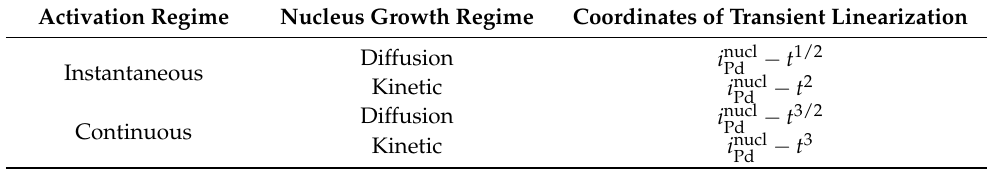
Table 1. Current transients of the anodic phase formation through 3D nucleation stages.